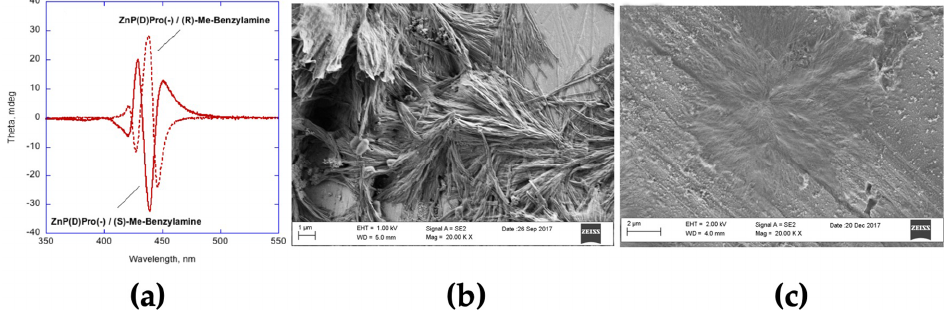
Figure 6. ( a ) CD spectra of ZnP(D)Pro( − ) aggregates (5 µ M; EtOH/H 2 O 25/75 v:v) in the presence of (R)-phenylethylamine (dotted line) and (S)-phenylethylamine (continuous line). SEM images of ZnP(L)Pro( − ) aggregates (10 µ M; EtOH/H 2 O 25/75 v:v) in the presence of (R)-phenylethylamine (1 mM) ( b ) and without added nitrogen ligand ( c ). Adapted from OPEN ACCESS [73].